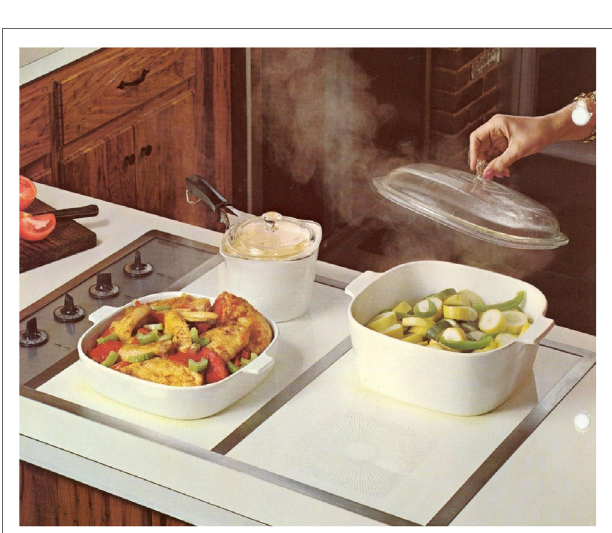
FiGURe 9 | First glass–ceramic cooktop: The Counter That Cooks ™ .